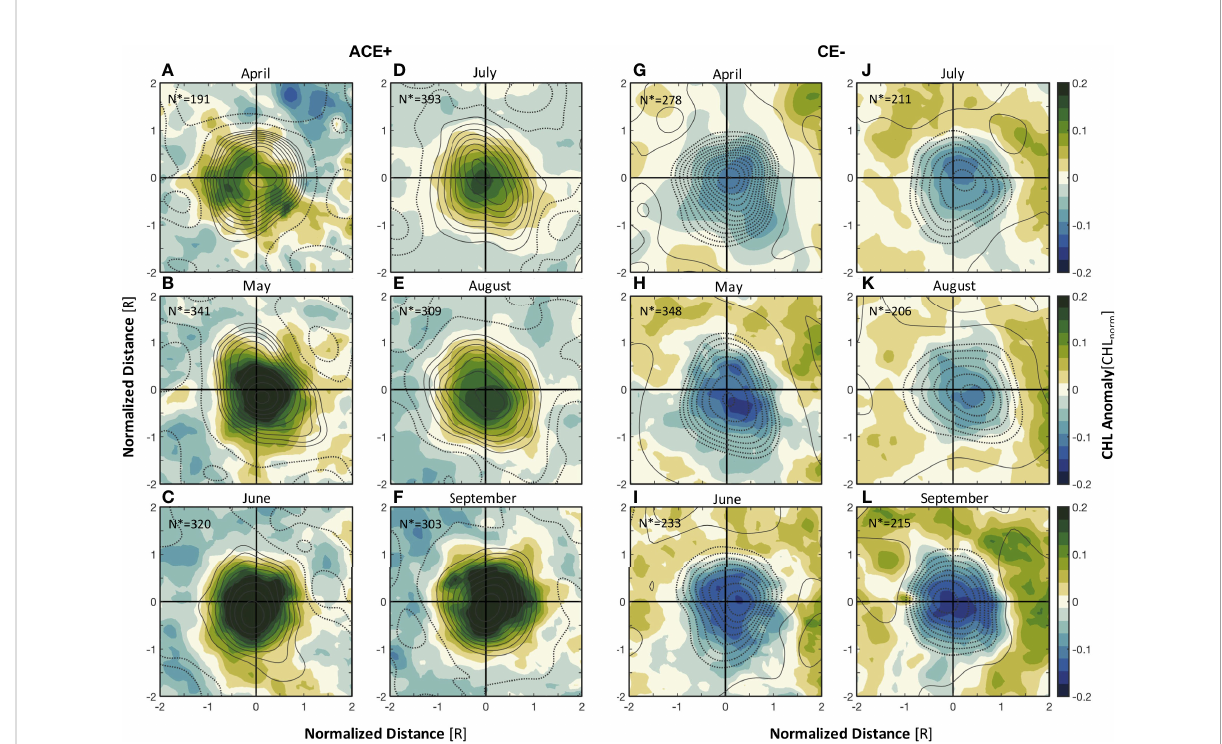
FIGURE 6 Monthly composites (April-September) of CHL anomalies for (A – F) ACE+ and (G – L) CE- in the northern Norwegian Sea for 2000-2020. The contours in (A – L) represent the composites of eddy-induced Ekman pumping (contour interval 1 cm d -1 ); solid lines correspond to upward pumping velocities, dashed lines correspond to downward pumping velocities. The x and y coordinates are normalized by the eddy radius (R). N* represents the number of eddy realizations for construction of the